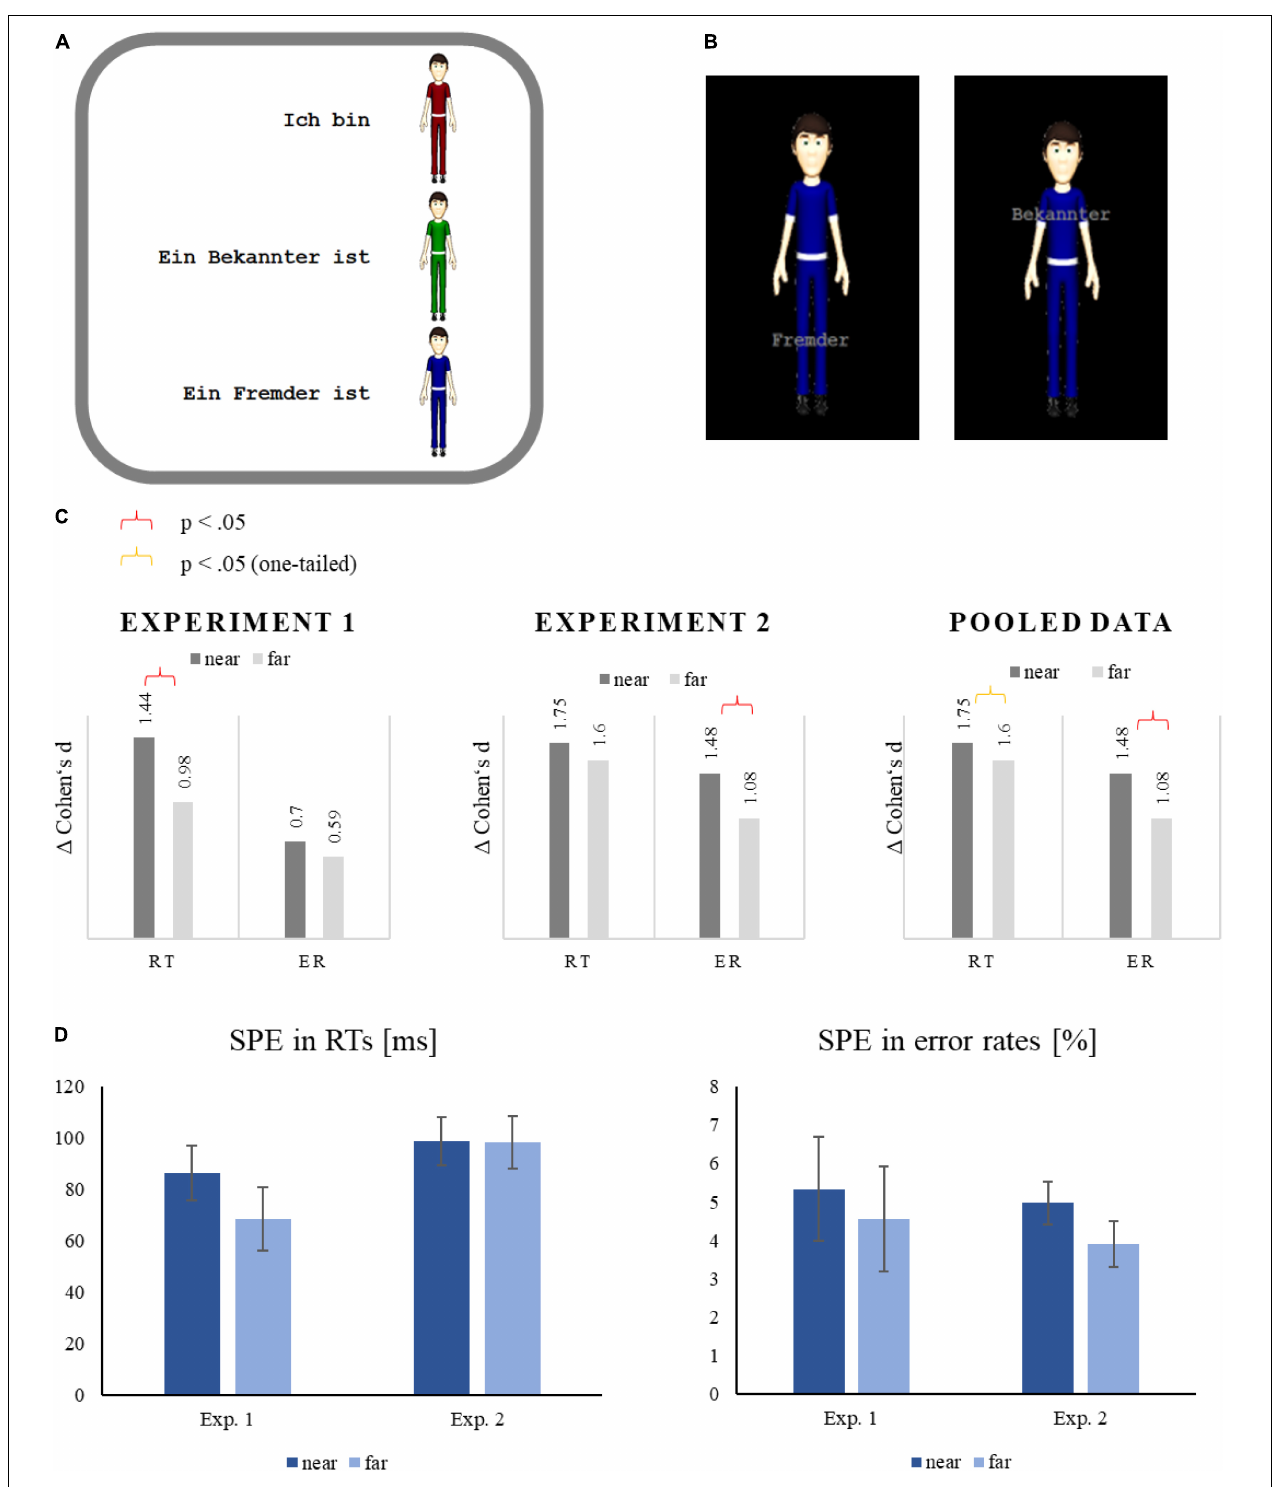
FIGURE 1 | Examples of the presentation of the avatars in the experiments (not drawn to scale) as well as the results: Note that (A,B) show the original stimuli used. Thus, the language is German. Translated into English (A) reads “I am [red avatar],” “An acquaintance is [green avatar],” and “A stranger is [blue avatar].” In (B) the labels translate to “stranger” at the feet and “acquaintance” at the torso. (A) The slide, which was presented for 60 s to learn the avatar associations, (B) matching-task trials with near or far label in Experiment 1, and (C) the effect sizes in the near and far condition in both experiments and pooled above experiment. (D) The SPE in RTs and error rates depending on the experimental condition and the